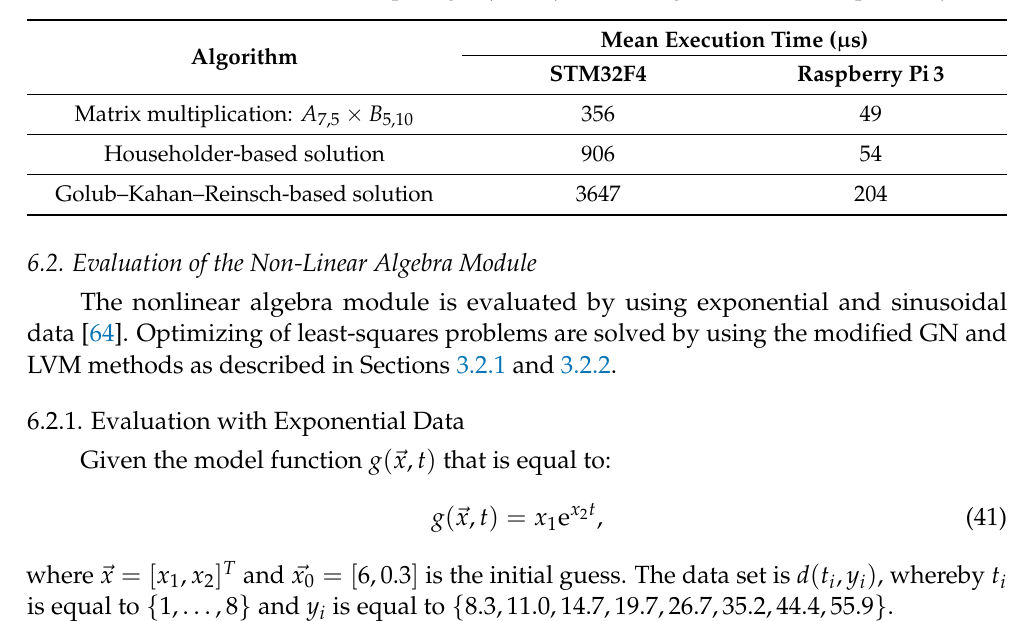
Table 3. Mean execution time of computing A 7,5